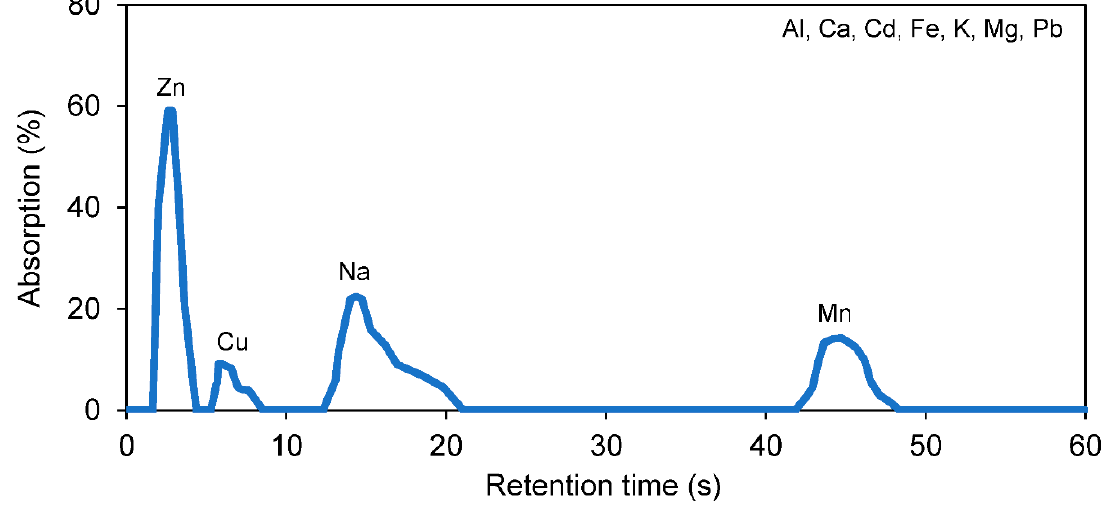
Figure 1. MMVSA peaks with a column at 2170 K of column temperature, 2220 K of vaporization temperature, and Ar 4.0 mL min − 1 carrier gas. Purge gas: Ar 3000 mL min − 1 + 200 mL min − 1 .